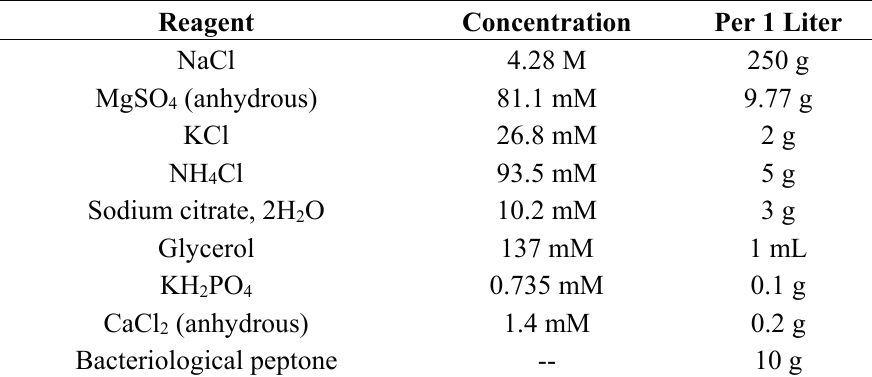
Table 1. Reagents required to prepare H. salinarum growth medium